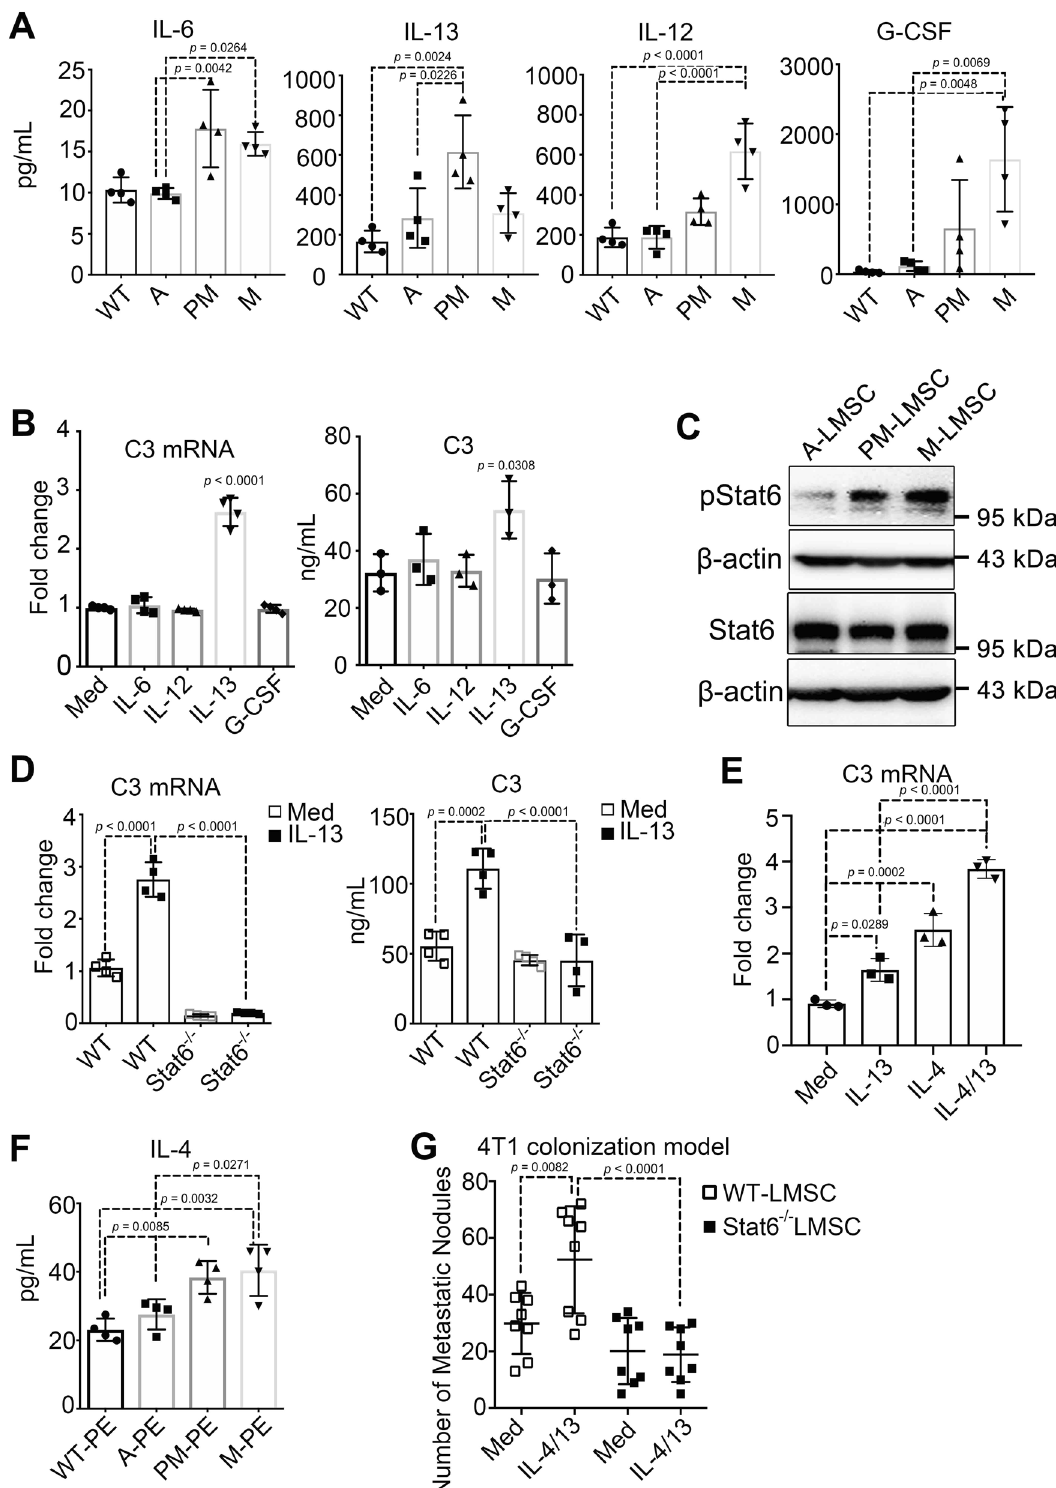
development using the Luminex microbead-based multiplex cytokine array assay. Four in fl ammatory factors, interleukin